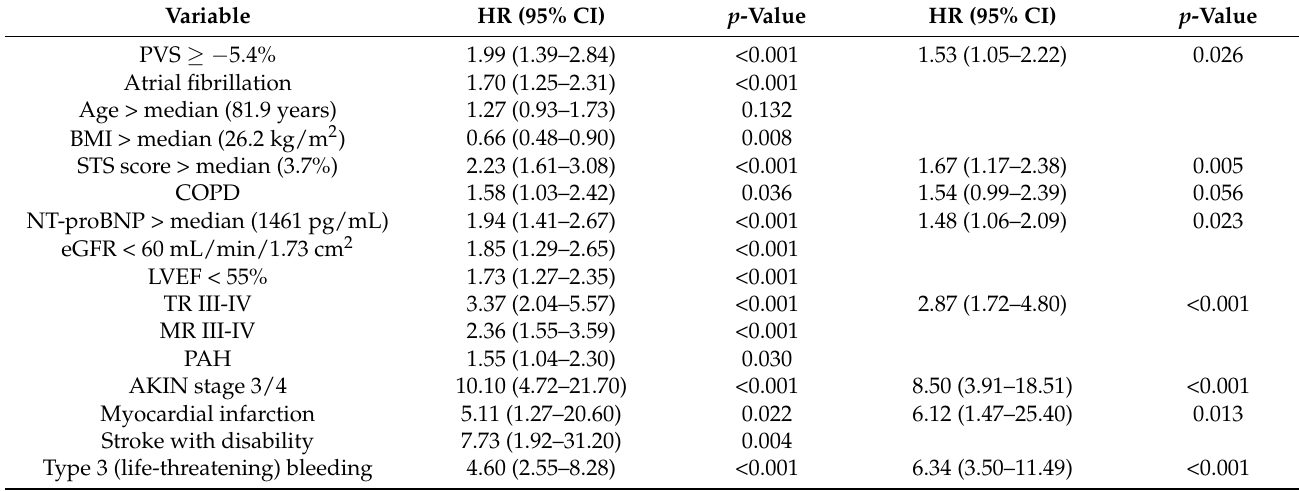
Figure 2. Elevated plasma volume status (PVS) is associated with adverse outcomes after tran- scatheter aortic valve implantation. ( A ) All-cause mortality. ( B ) Heart failure hospitalization. Legend: Kaplan-Meier survival curves for the secondary endpoints of all-cause mortality and heart failure hospitalization comparing patients with a PVS ≥ − 5.4% (congestion) to patients with a PVS < − 5.4% (no congestion). Table 3. Cox regression analysis for the primary composite endpoint of all-cause mortality or heart failure